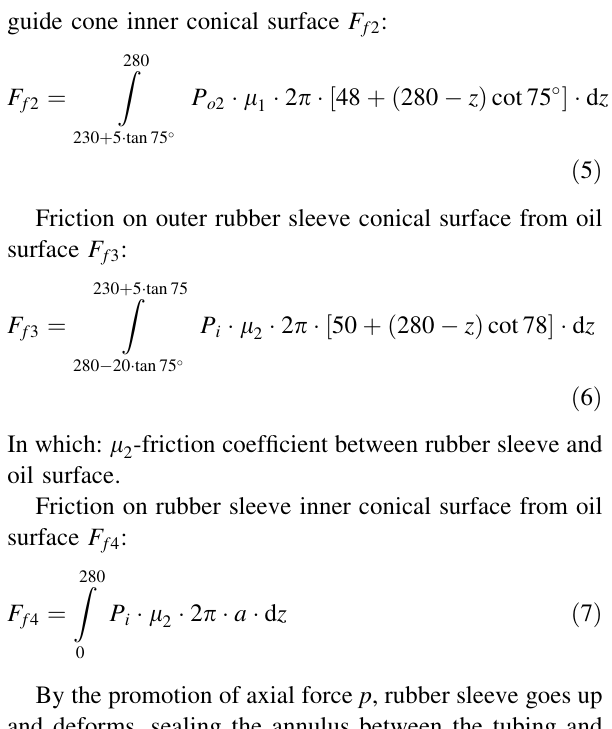
Fig. 8 Structure diagram of guide cone